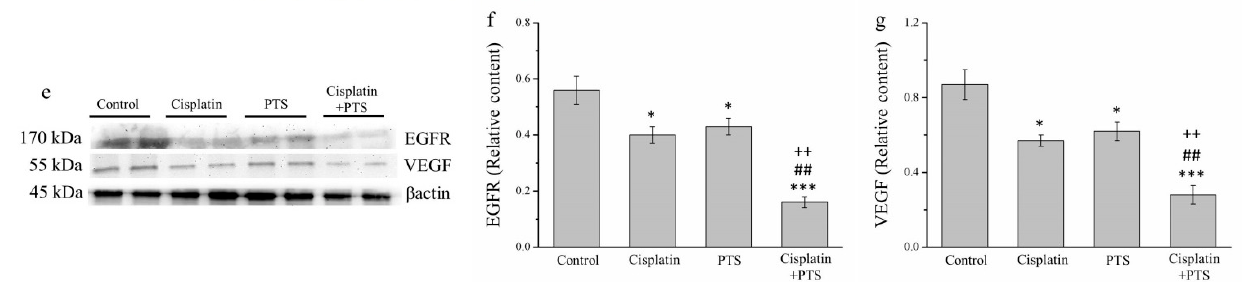
Figure 6. Analysis of factors related to metastasis in M5 canine melanoma tumors implanted in BALB/c nude mice. ( a – d ) Representative images ( a , c ) and quantitative comparisons ( b , d ) from our IHC analysis of CD44 ( a , b ) and TGF- β ( c , d ) expression. ( e – g ) Representative Western blot ( e ) from our analysis of the relative expression of EGFR ( f ) and VEGF ( g ). The mice were adminis- tered the following treatments three times per week: saline (control), 2 mg/kg cisplatin (cisplatin), 100 mg/kg PTS (PTS), or 100 mg/kg PTS and 2 mg/kg cisplatin (cisplatin + PTS). Data are presented as mean ± SD, n = 7 per group. * p < 0.05, ** p < 0.01, and *** p < 0.001 vs. control; ## p < 0.01 vs. cisplatin; ++ p < 0.01 vs. PTS. Scale bars: 50 µ